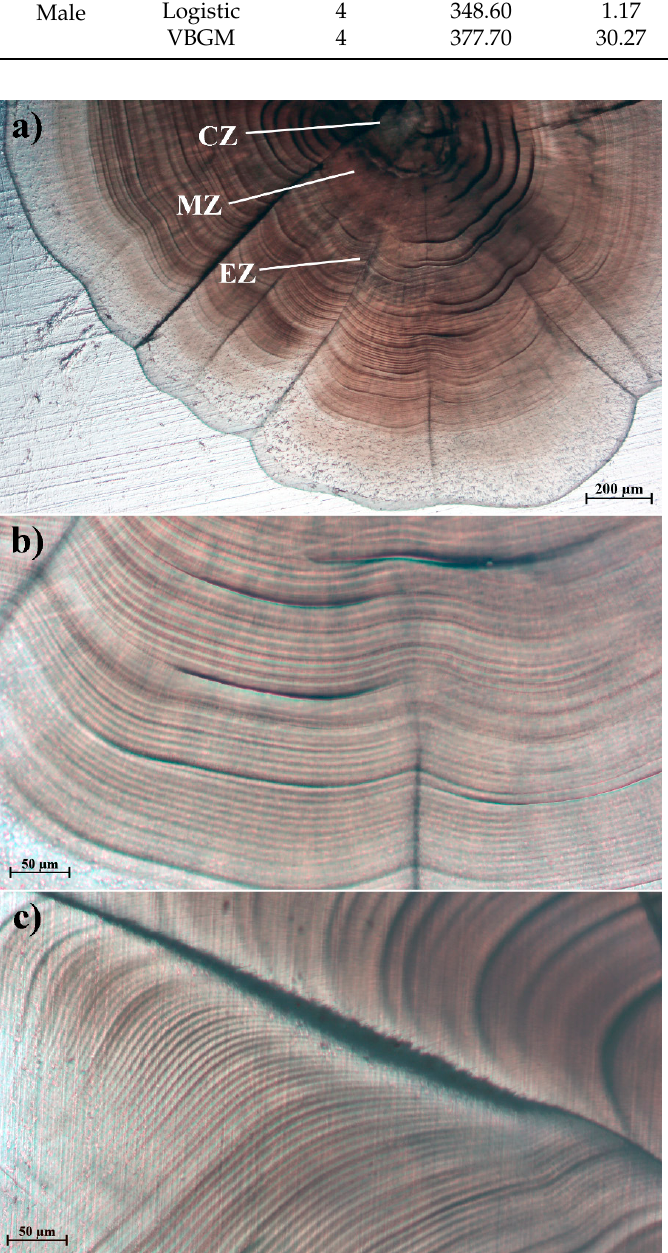
Figure 4. Sagittal section of an otolith of Myctophum punctatum observed by light microscope, showing the growth pattern and otolith zones; ( a ) otolith zones: CZ = central zone; MZ = middle zone; EZ = external zone; ( b , c ) microincrement pattern in two different areas of the EZ.